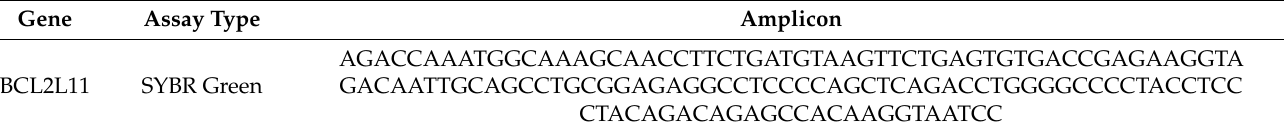
Table 2. Genes used for real-time quantitative polymerase chain reaction